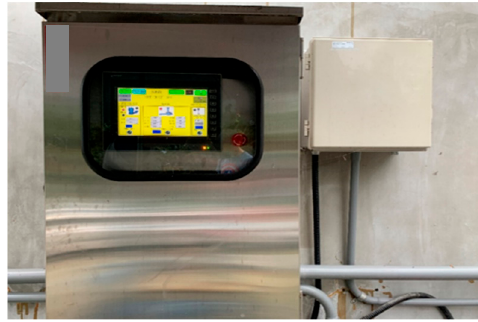
Figure 3. The human–machine interface (HMI) (yellow panel) of the programmable logic controller (PLC) for automatic SBR operation control.